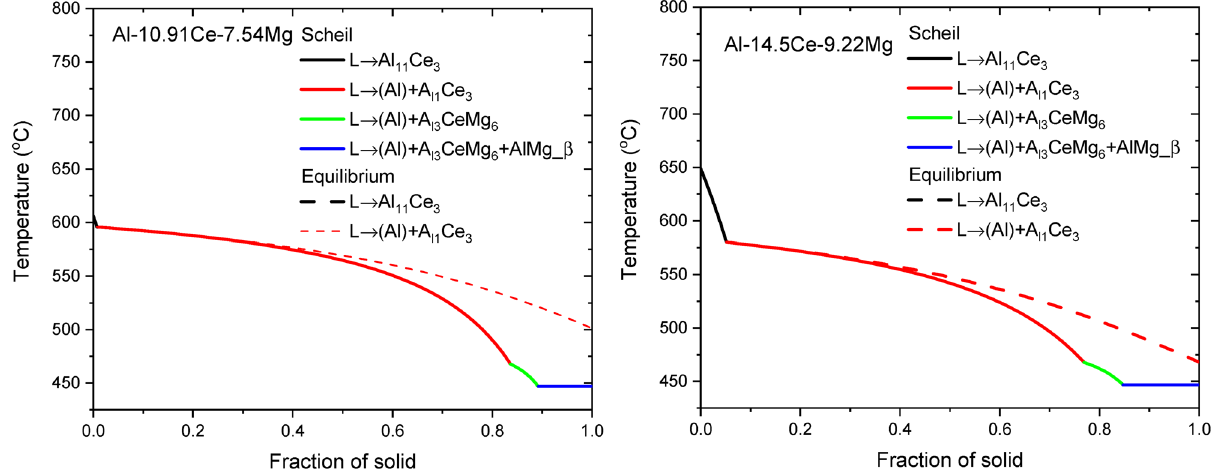
Figure 10. Scheil and Equilibrium Solidification Diagrams of Alloys Near Eutectic and Hypereutectic Respectively. The Calculation was done with the Chemical Composition of the